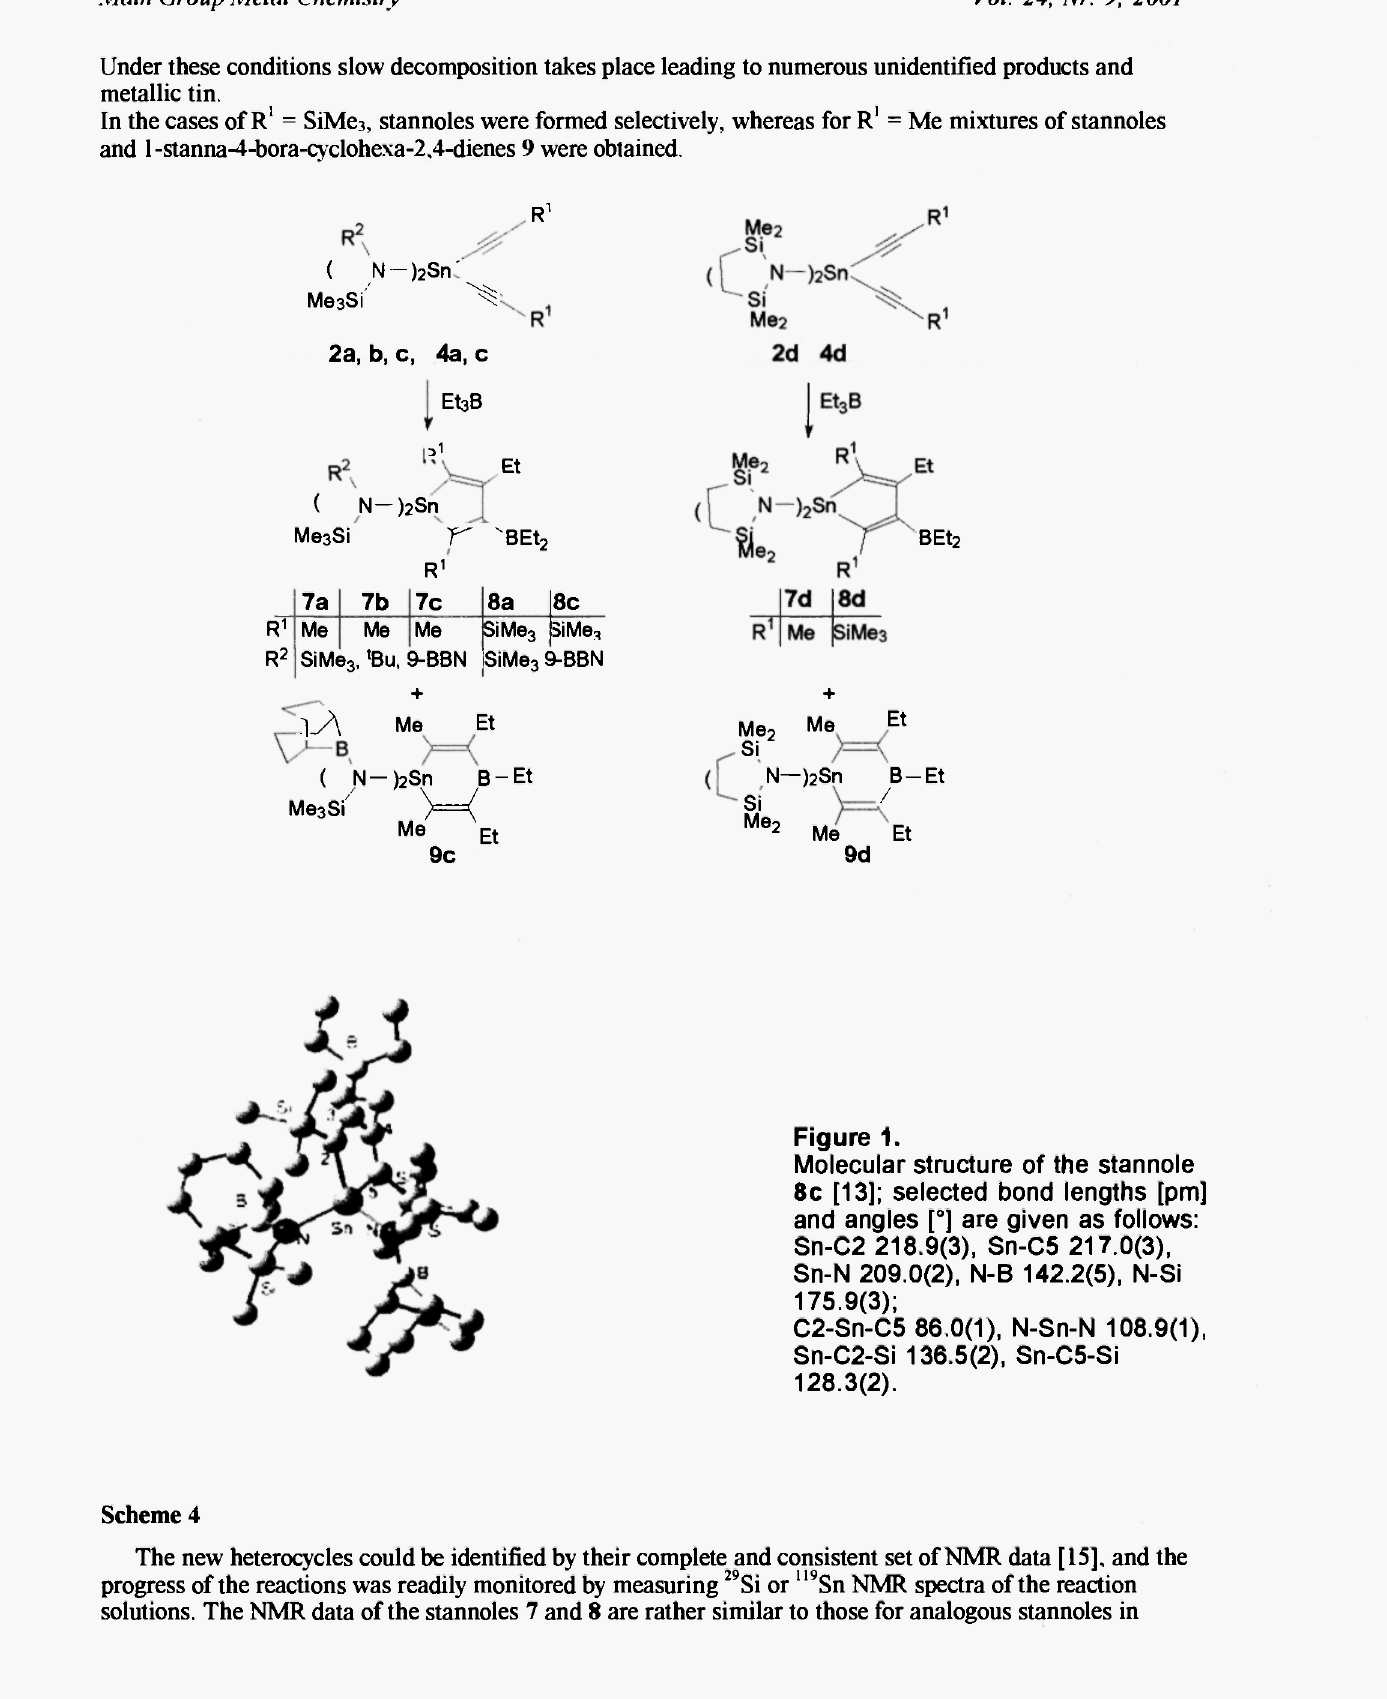
Figure 1. Molecular structure of the stannole 8c [13]; selected bond lengths [pm] and angles [°] are given as